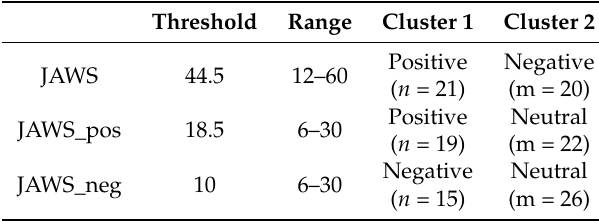
Table 1. Distribution of psychological data within